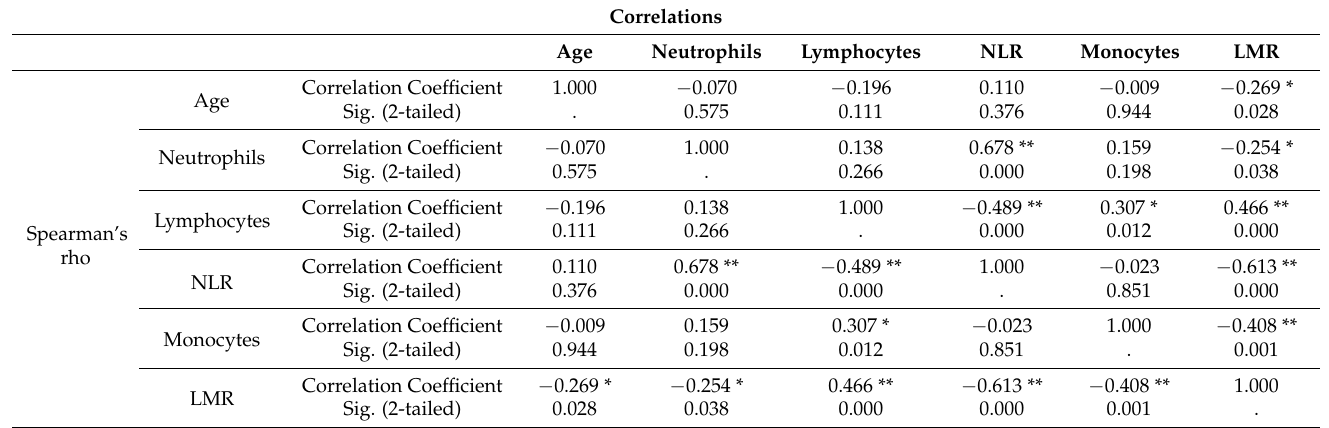
Table 4. Spearmen’s correlation for study population with IMPROVE score ≥ 4